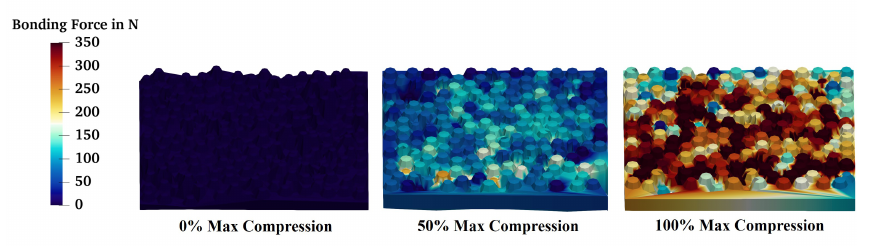
Figure 40. Grit 20 surface topography with bonding force at 0%, 50%, and 100% maximum compression.